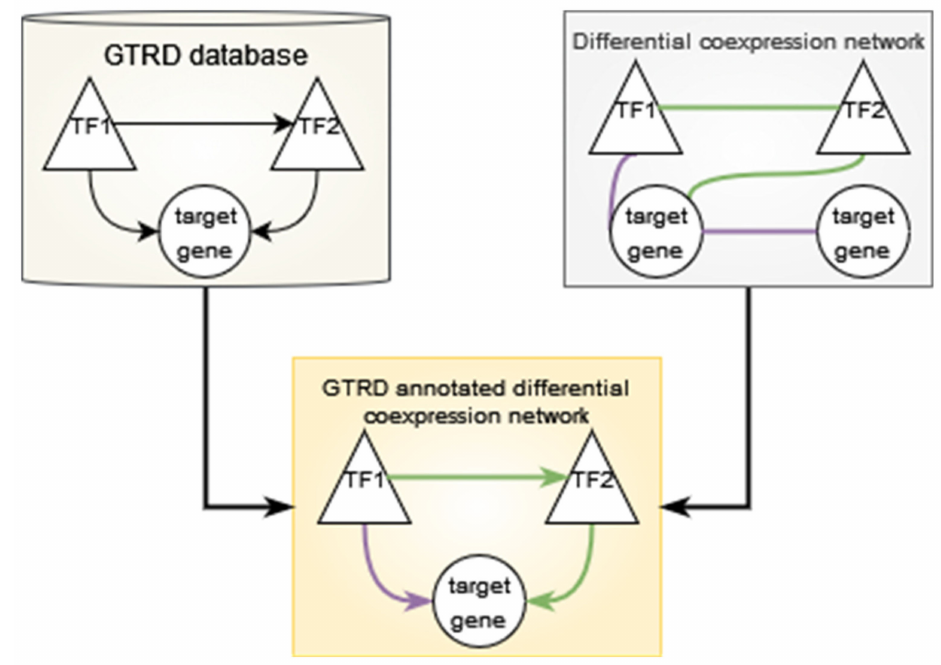
Figure 2. Construction of the GTRD-annotated differential co-expression network. The GTRD database contains transcription factors (triangles) and target genes (circles). The presence of a binding site for the transcription factor in the promoter region of the target gene is shown by an arrow pointing from the transcription factor (TF) to the target gene. A TF–TF interaction is also shown. The differential co-expression network has gene pairs that show significantly increased edge weights (purple connector) or significantly decreased edge weights (green connector) in the comparison. The connections are not directed (connector without arrow) and may occur between any two genes. The GTRD-annotated differential co-expression network has TF–TF edges or TF–target gene edges if the edge is present in both GTRD and the differential co-expression network. The direction for the edge is annotated using GTRD. Purple arrows show a TF–target gene or TF–TF interaction where the edge weight is increased, and green arrows show one where the edge weight is decreased. There are no target gene–target gene edges in this